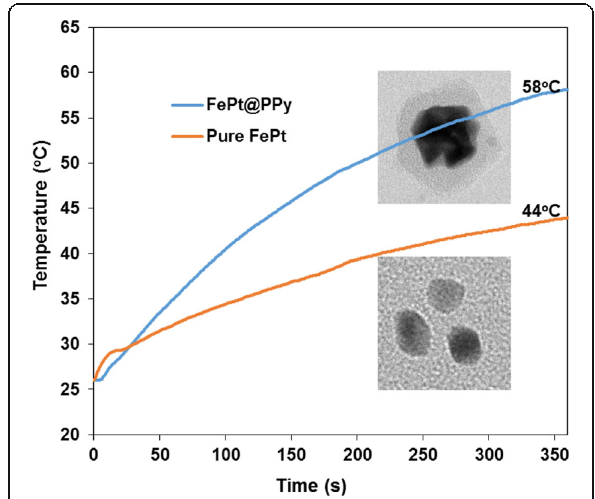
Fig. 4 Photothermal heating curve of pure FePt NPs and FePt@PPy NPs with the same amount of FePt. All solutions were irradiated with a 1-W/cm 2 808-nm laser for 6 min